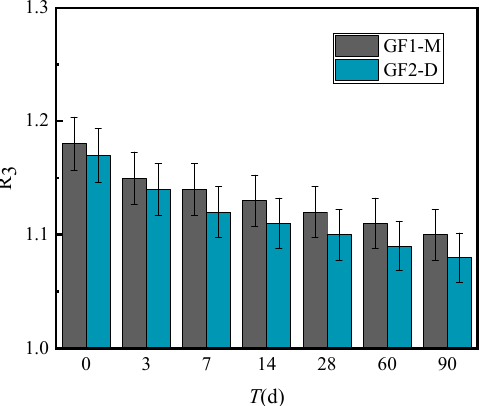
Figure 10. Resilience modulus ratio of VGM-30 and general gradations.